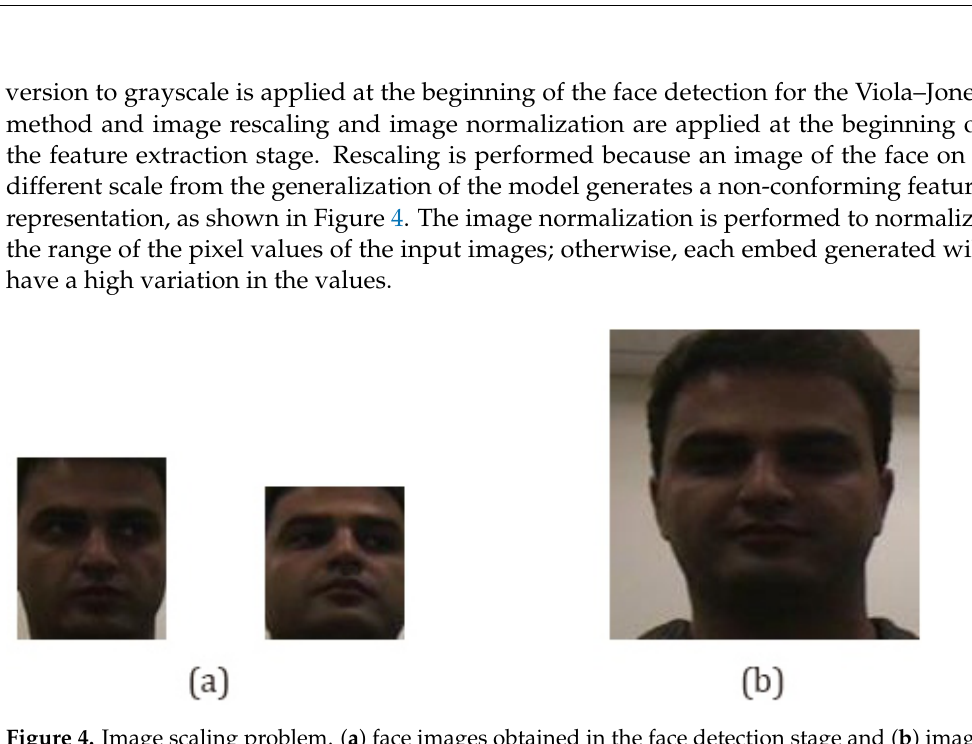
Figure 4. Image scaling problem. ( a ) face images obtained in the face detection stage and ( b ) image scale of the model training